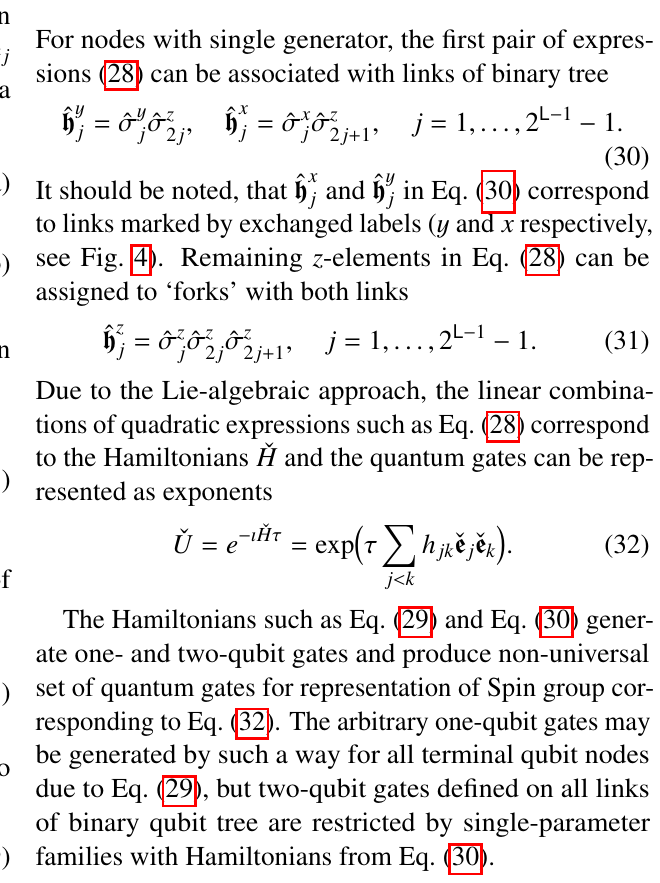
-trees for L = 3 and L = 4 L